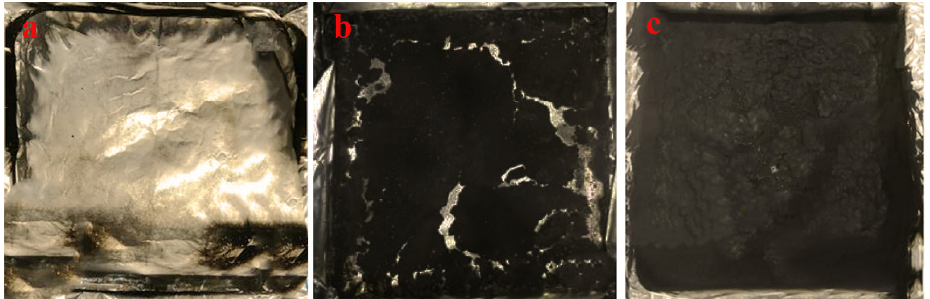
Figure 9. Digital photos of the char residues after the CCT test: ( a ) HIPS; ( b ) HIPS/IFR; and ( c ) HIPS-2.